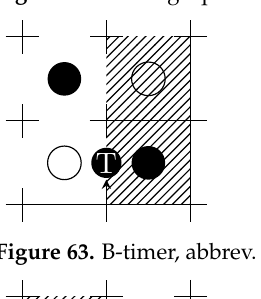
Figure 62. Parking squares.